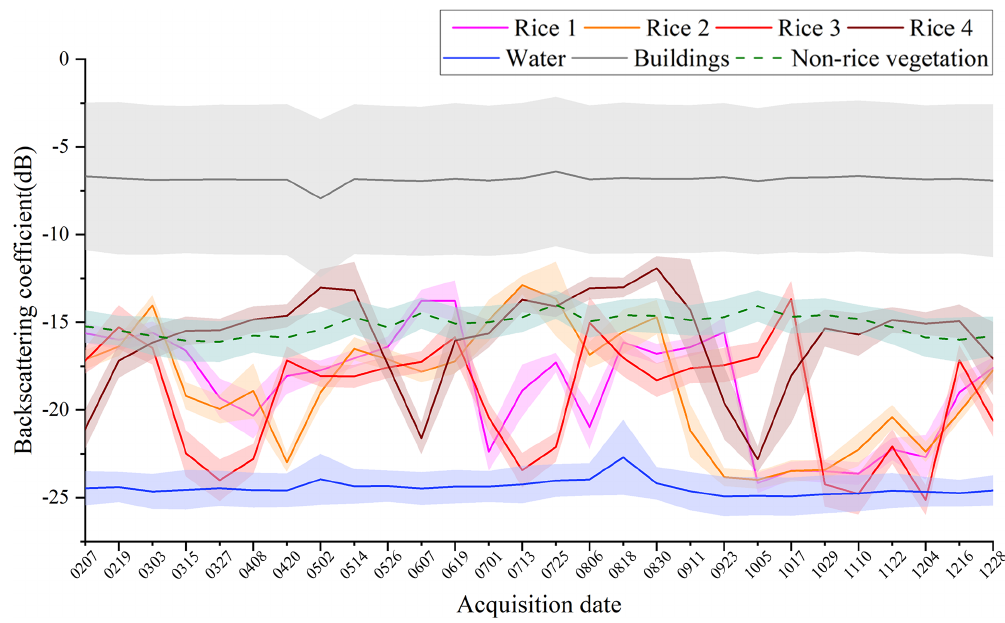
Figure 3. The average VH polarization backscattering coefficient curve of typical land covers (the shaded areas refer to the standard deviation calculated from the sample